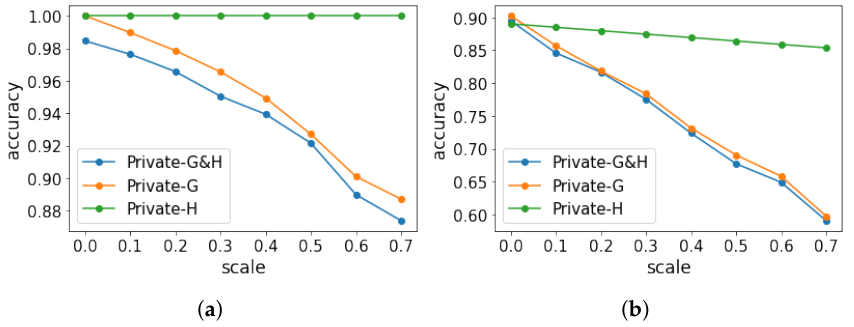
Figure 5. Relationship between scale parameters and test accuracy on the task of rice traceability based on multi-classification differentially private XGBoost. δ = 10 − 5 and the number of iterations is 100. Where ( a , b ) represent the experimental results of the three classification and the four classification task